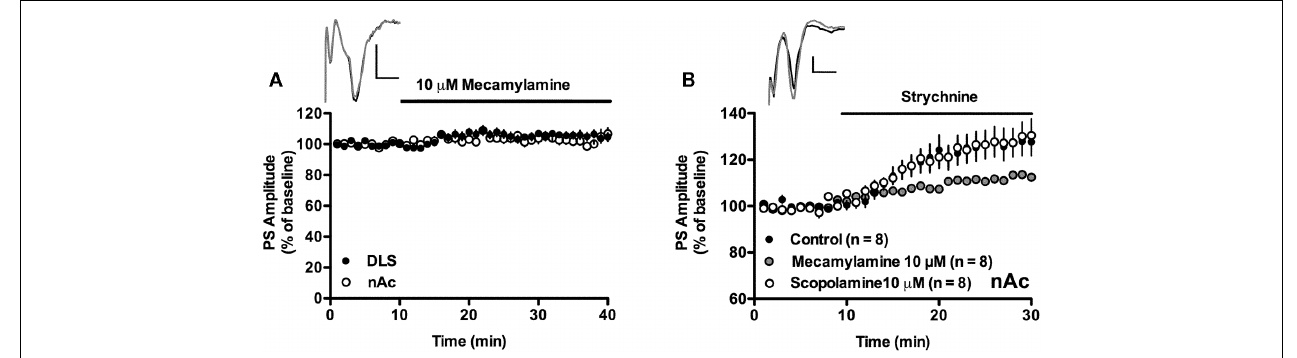
PS amplitudes recorded in the nAc core remained in slices treated with the muscarinic acetylcholine receptor antagonist scopolamine (10 μ M), but was significantly depressed in mecamylamine-treated slices. Example traces show evoked population spikes at baseline (gray) and after 15–20min of strychnine administration in a scopolamine-treated slice (black). Data show mean PS amplitudes compared to baseline with SEM. Calibration: 0.2mV,